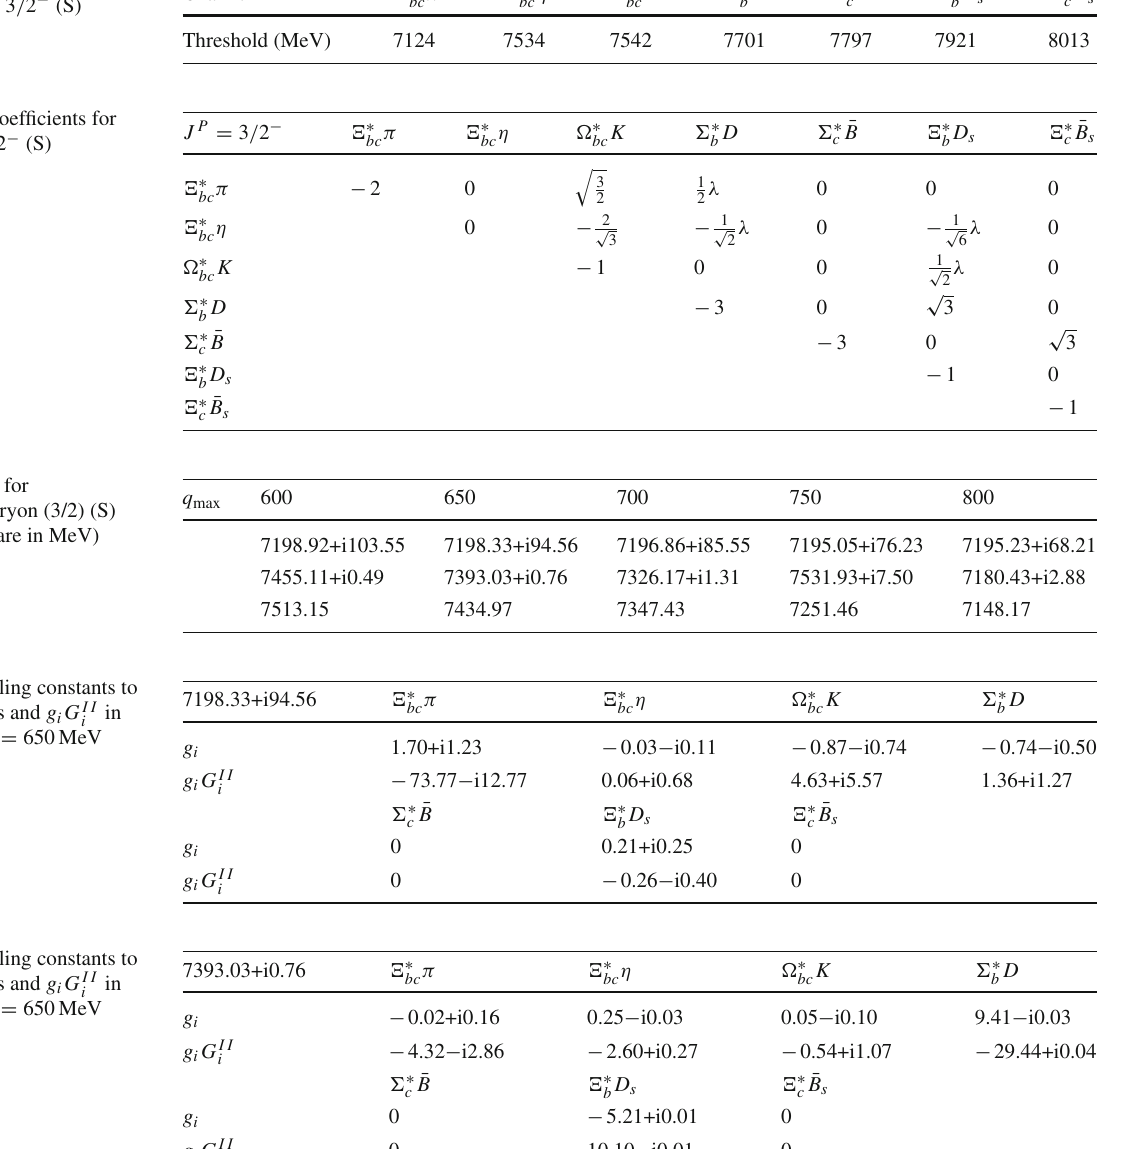
Table 29 Channels considered for sector J P = 3 / 2 − (S)